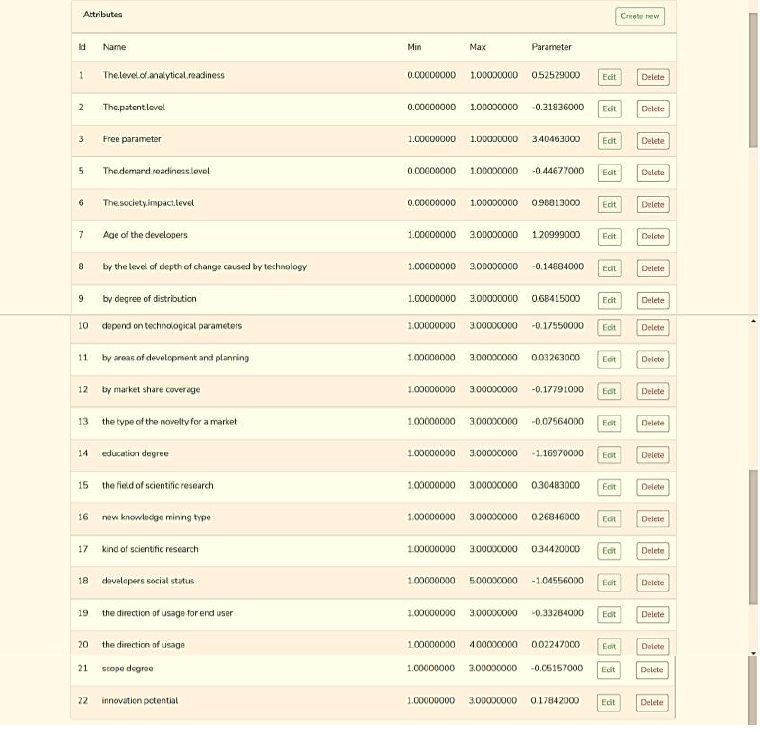
Figure 11. Web page for model parameters.